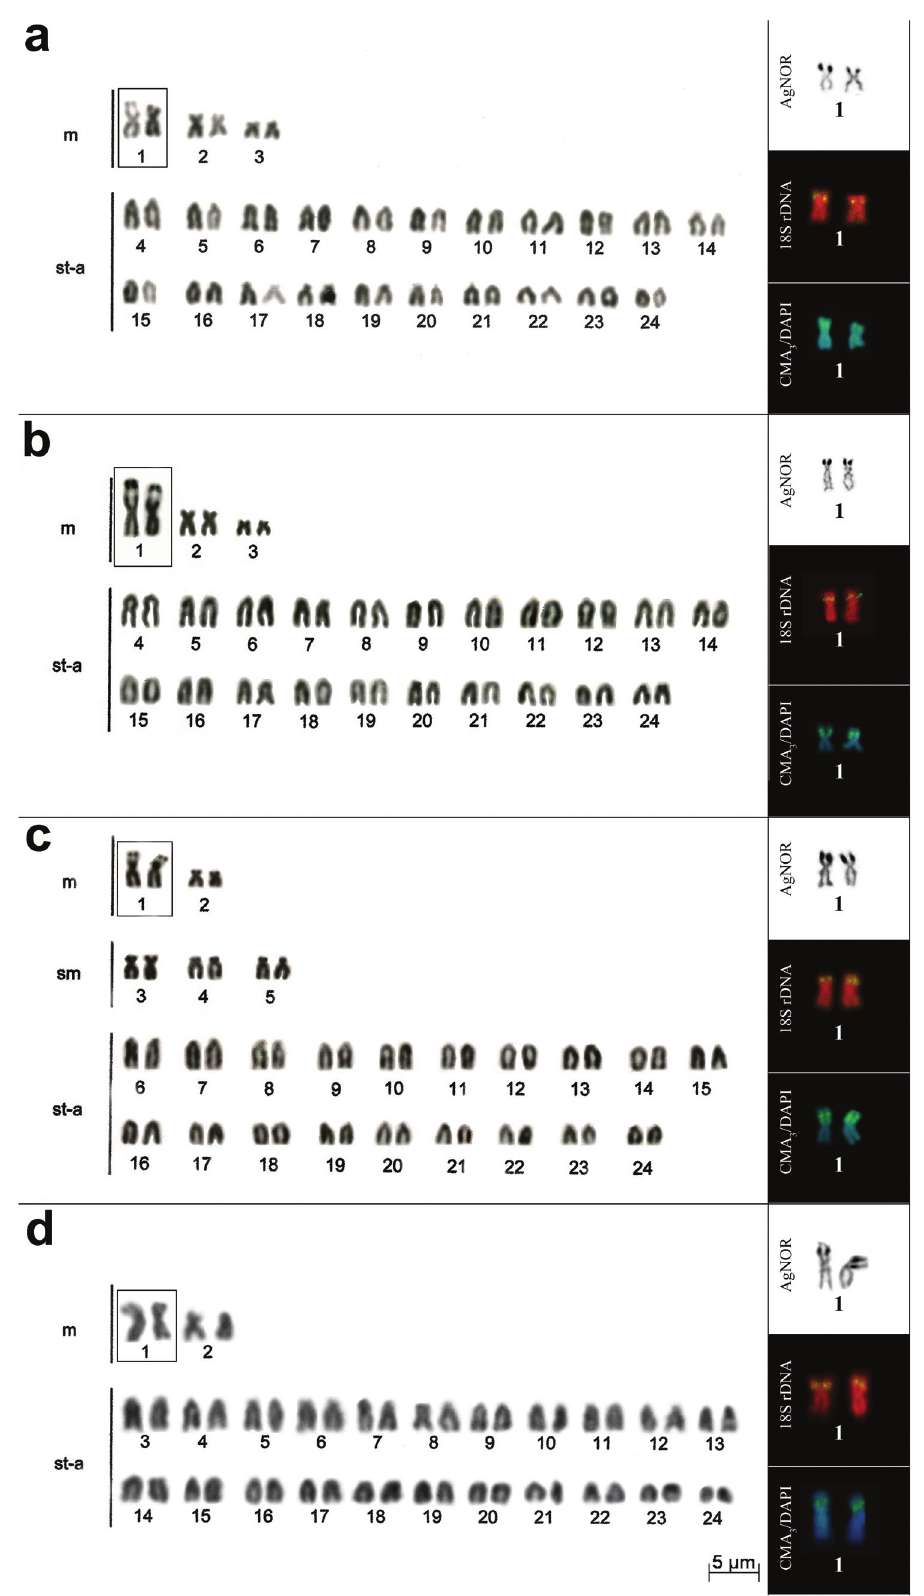
Figure 2 - Karyotype and chromosome pairs with silver nitrate staining, FISH with 18S rDNAr probe and CMA 3 /DAPI in: Crenicichla maculata (a), C. lepidota (b), C. punctata (c) and C. semifasciata (d), respectively. In the boxes are secondary interstitial constrictions in the short arm of the first metacentric